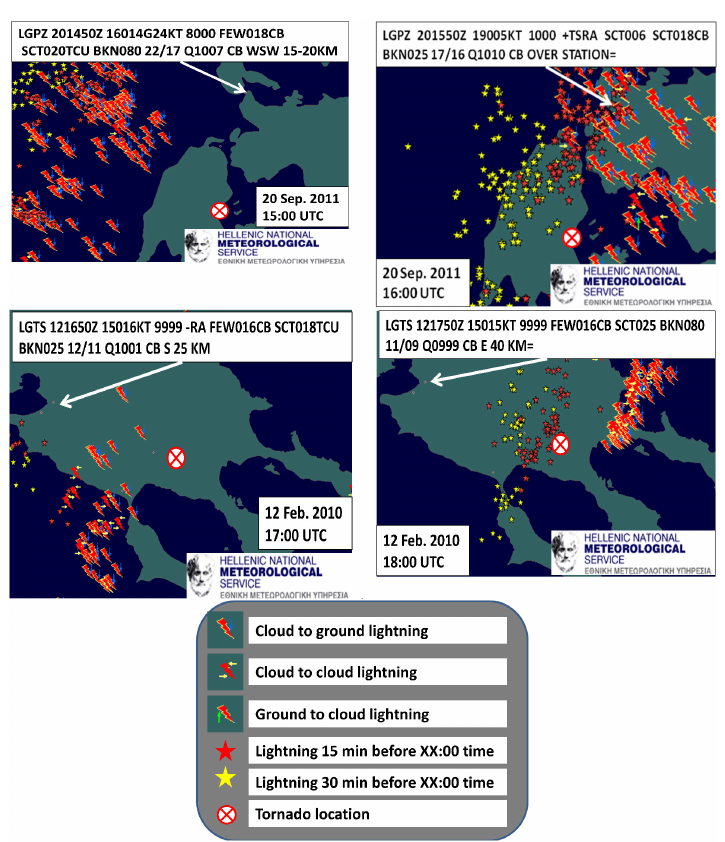
Figure 4. Visualization of lightning distribution in a 15min step, associated with the T11 (upper images) and T10 (lower images) events. Red and yellow stars represent the spatial distribution of lightning activity 15 and 30min prior tornado formation, respectively. Tornadoes developed within the above hourly time window and the red X in a red circle denotes the location. METAR data from the closest weather stations, Preveza (LGPZ) and Thessaloniki (LGTS) for T11 and T10, respectively, were also